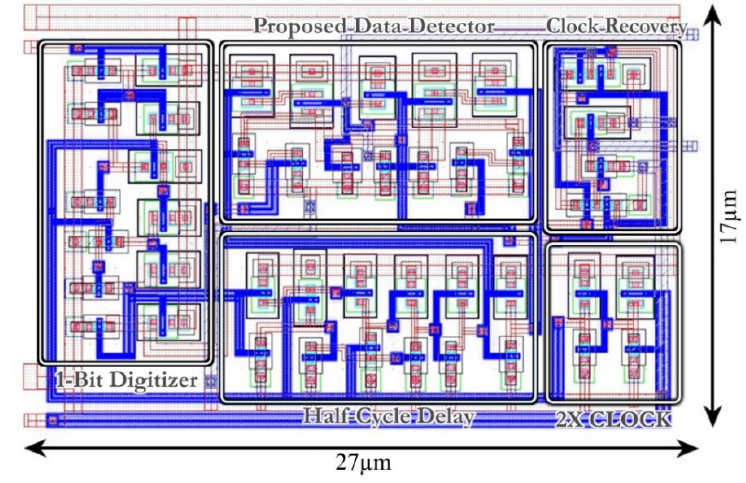
Figure 6. Layout view of the presented circuit.